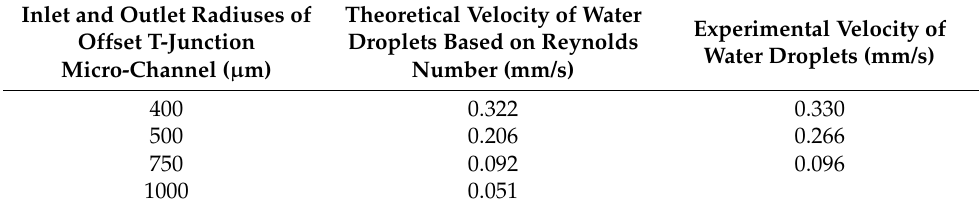
Figure 4. The motion of water droplets after 364 ms within radiuses of ( a ) 400 µm, ( b ) 500 µm, and ( c ) 750 µm offset T-junction microchannels. Table 3. Theoretical and experimental velocity of water